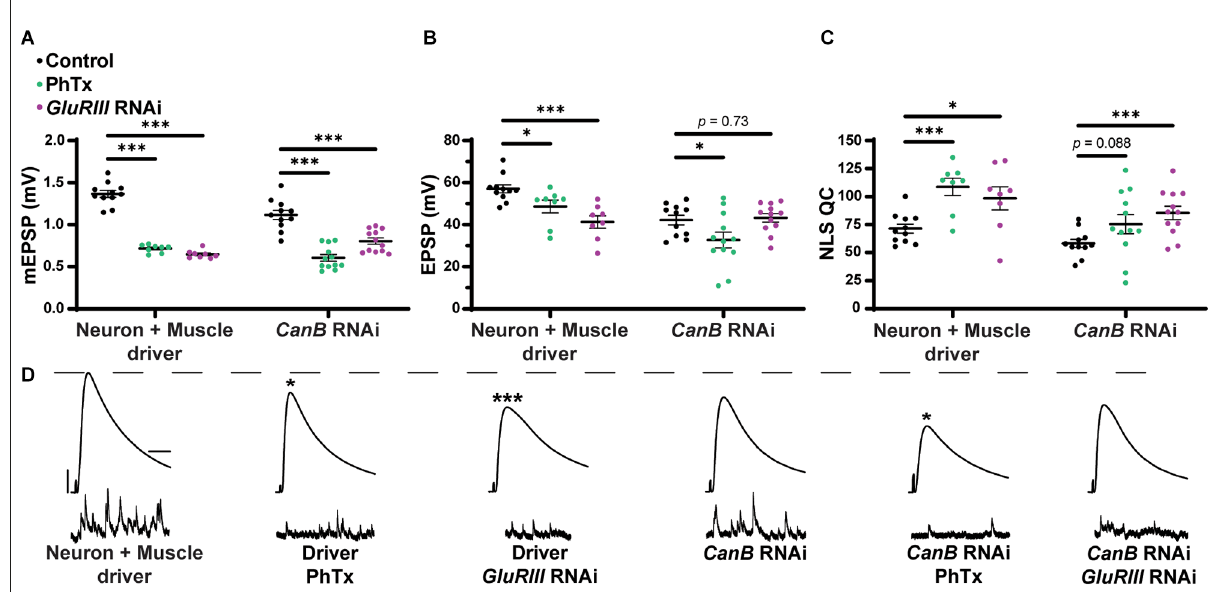
FIGURE12 Dualpre-andpostsynapticknockdownof CaNB doesnotblockPHPwhileknockdowninmusclealoneprecludedthemaintenanceofPHP. (A–C) Quantification showing average mEPSP amplitude, EPSP amplitude, and NLS quantal content in pre + post-GAL4 control and pre + post-GAL4 driven CaNB RNAi. Black points show DMSO control synapses, green points show synapses treated with PhTx, and magenta points show animals chronically challenged with GluRIII RNAi. (D) Representative electrophysiological traces of EPSPs (above) and mEPSPs (below). Scale bars for all traces are y = 10 mV (1 mV), x = 20 ms (500 ms) for EPSPs (mEPSPs). ∗ p < 0.05, ∗∗∗ p < 0.001 by Multiple Student’s T-test and corrected for multiple comparisons using the Holm-Sidak method. DMSO controls were compared to PhTx and GluRIII RNAi synapses for driver controls and separately for CaNB